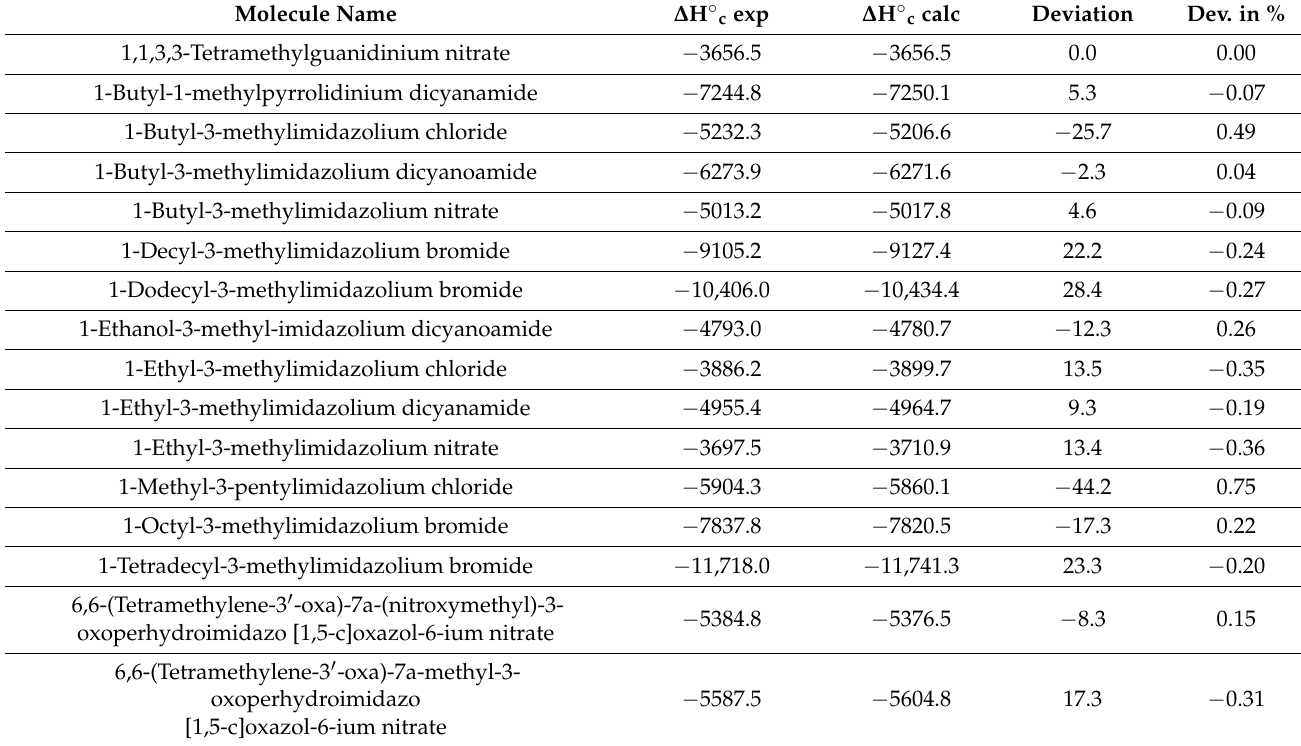
Table 8. Calculated and experimental ∆ H ◦ (c) (in kJ/mol) of some Ionic Liquids. Molecule